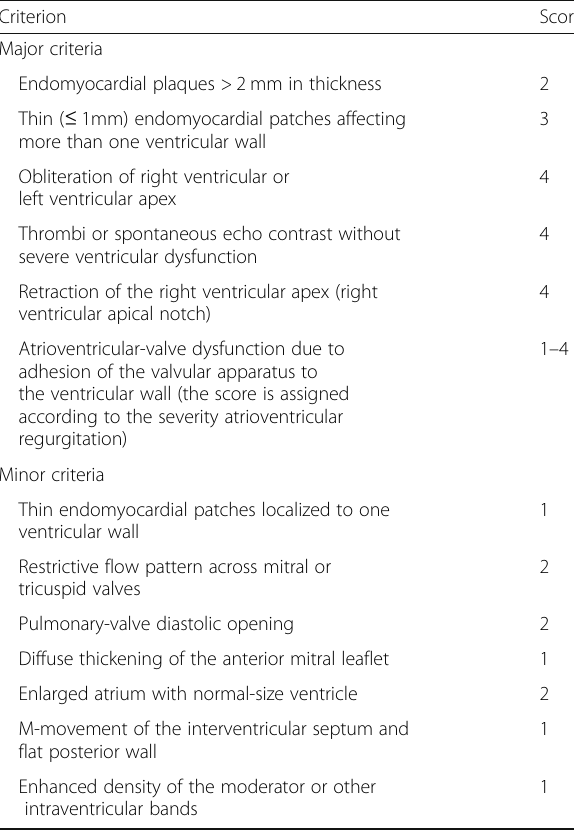
Table 1 Criteria for diagnosis and assessment of the severity of endomyocardial fibrosis